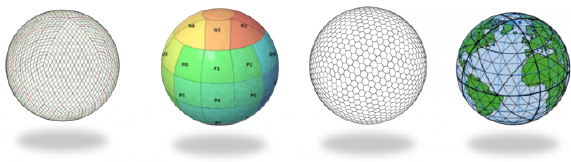
Figure 4. Discrete Global Grid System